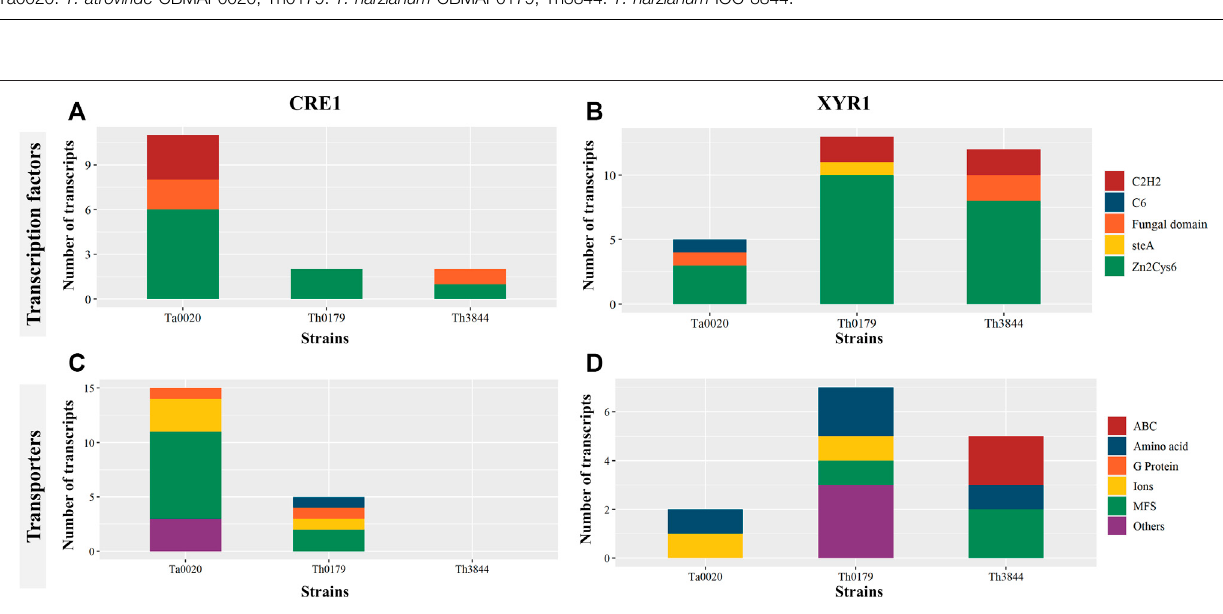
FIGURE 5 | Distribution of TFs and transporters in the cre1 and xyr1 groups in Trichoderma spp. Classi fi cation of TFs coexpressed with cre1 (A) and xyr1 (B) and transporterscoexpressedwith cre1 (C) and xyr1 (D) inTh3844,Th0179,andTa0020.TheTFsandthetransporterswereclassi fi